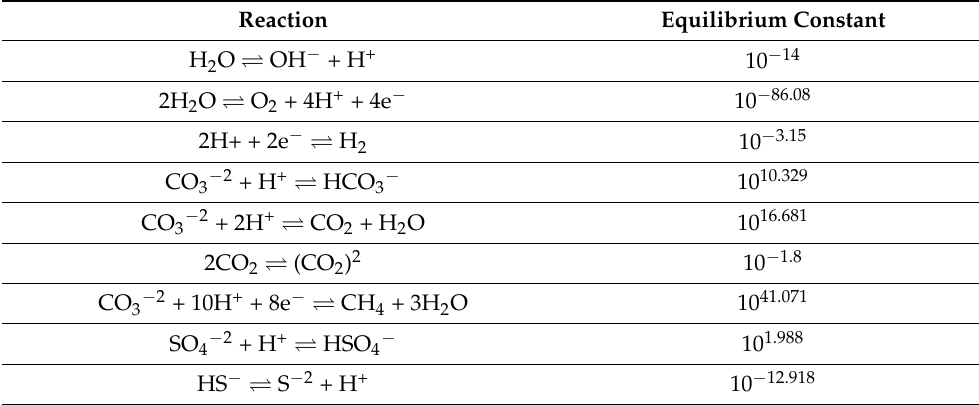
Table 2. Various aqueous reactions along with equilibrium constants at 25 ◦ C [36].